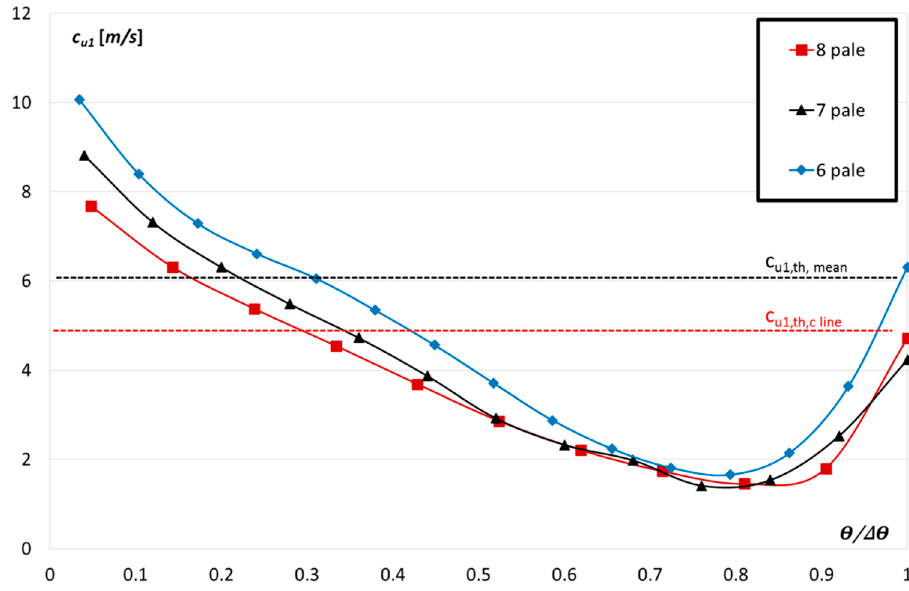
Figure 9. Trend of the absolute tangential velocity calculated on the iso-clips with Equation (4). c u 1, th , mean = 6.03 m/s, c u 1, th , c line = 4.77 m/s.